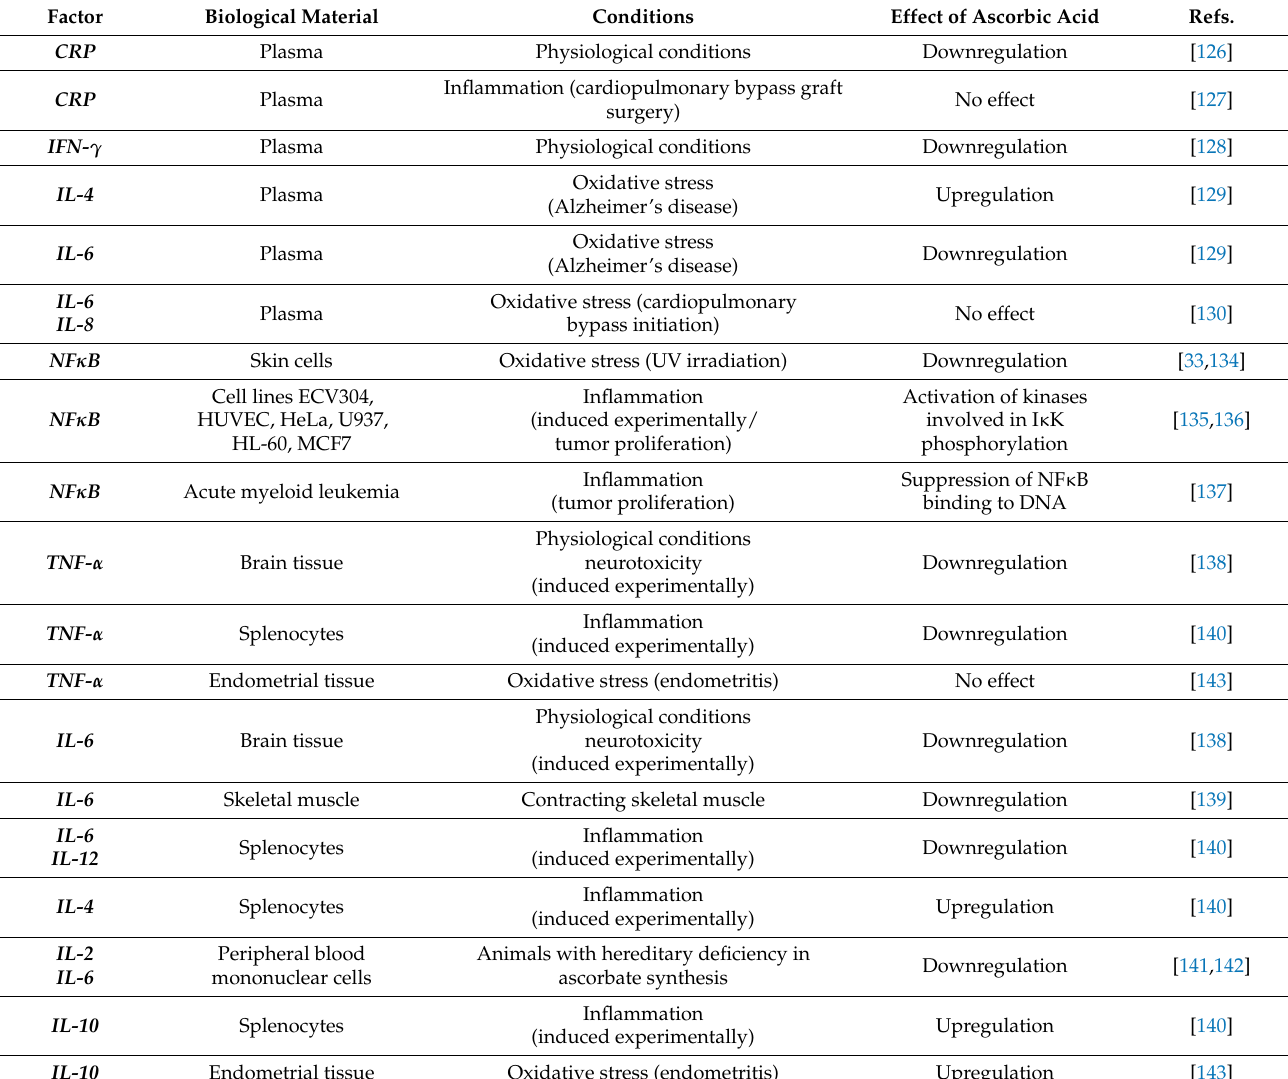
Table 2. Summary of the effects of ascorbate on individual inflammatory responses. Conditions Effect of Ascorbic Acid